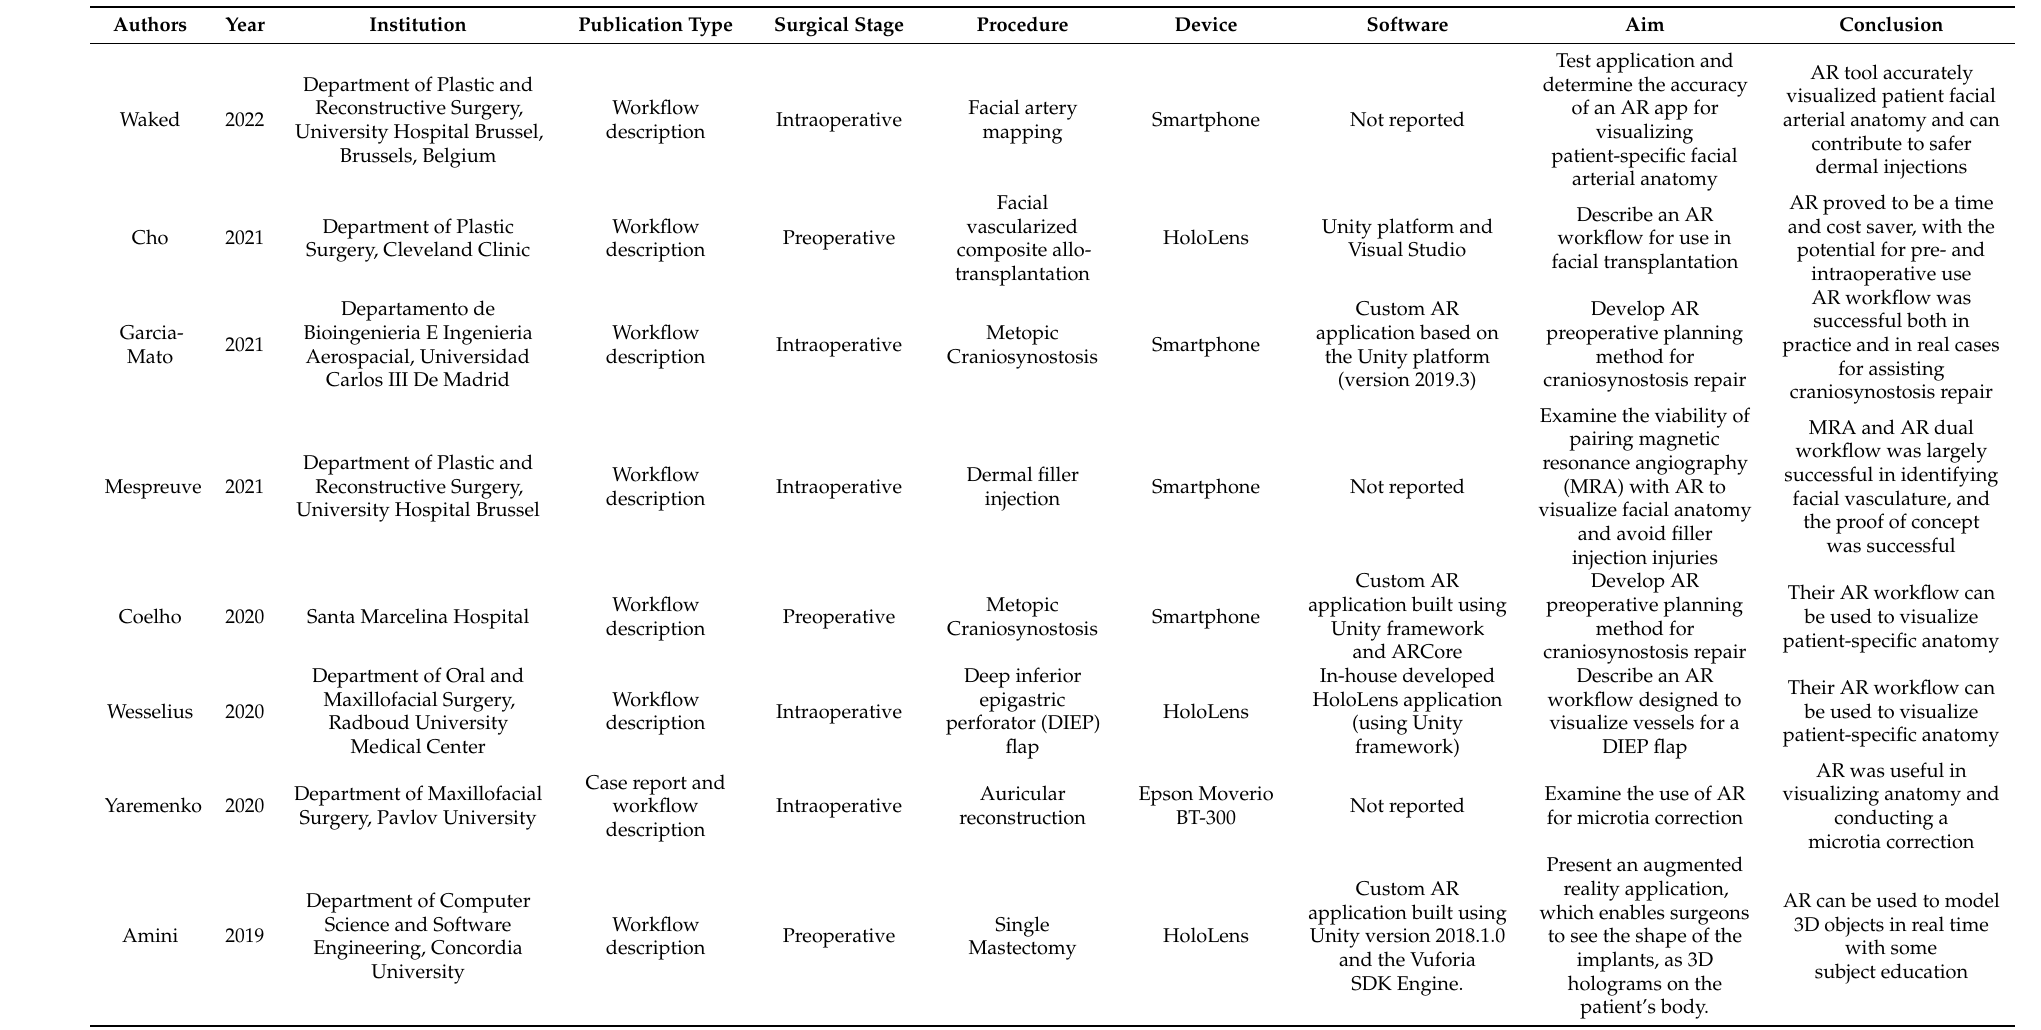
Table 1. Included studies and their